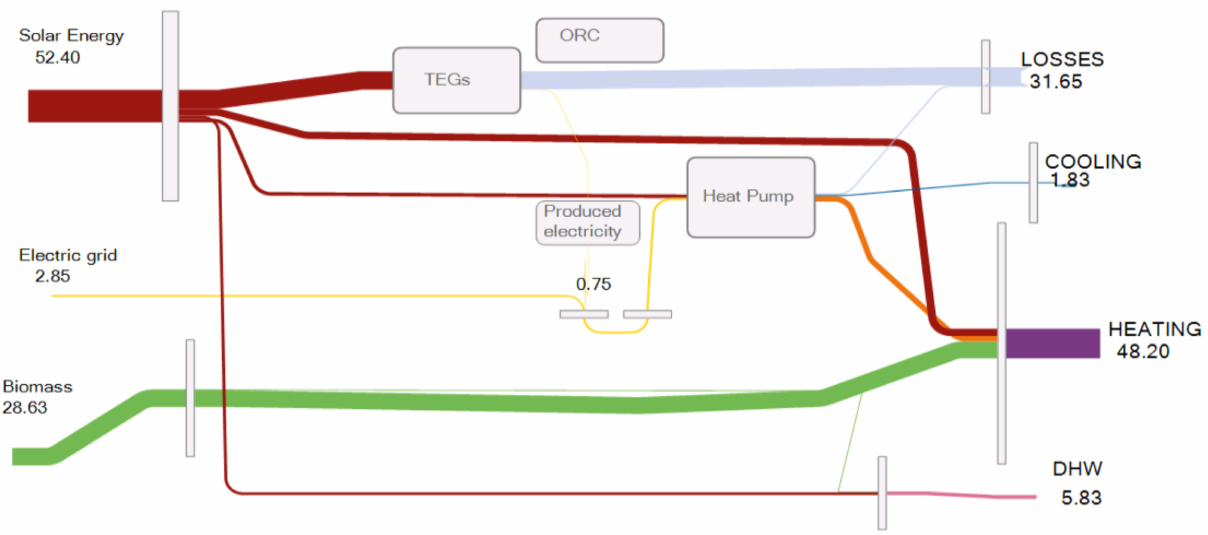
Figure 8. Sankey diagram for Helsinki 100% rooftop coverage with solar collectors. All energy flows are in kWh/(m 2